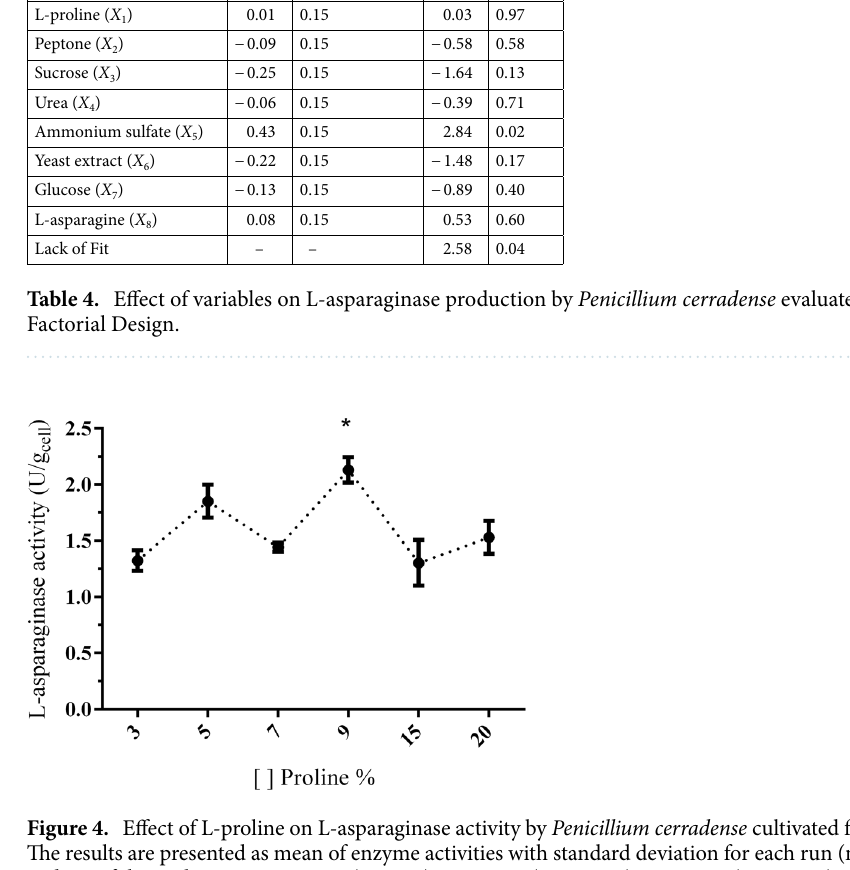
Fig. 4. The L-proline substrate concentration of 9% differs significantly from 3 and 7%. The enzymatic activity at 9% corresponds to approximately 1.6 times greater than the one found in lower concentration. In the medium